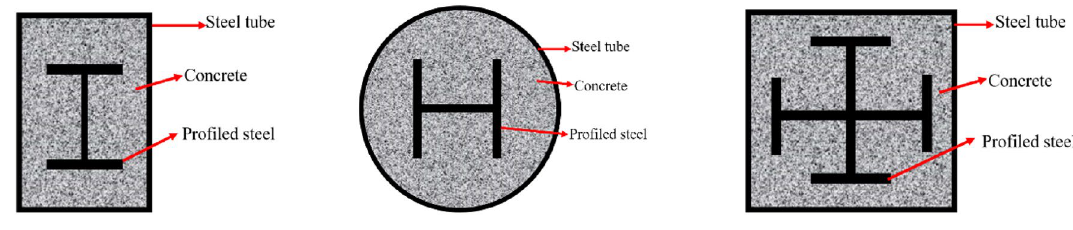
Figure 1. Cross-sectional shapes of